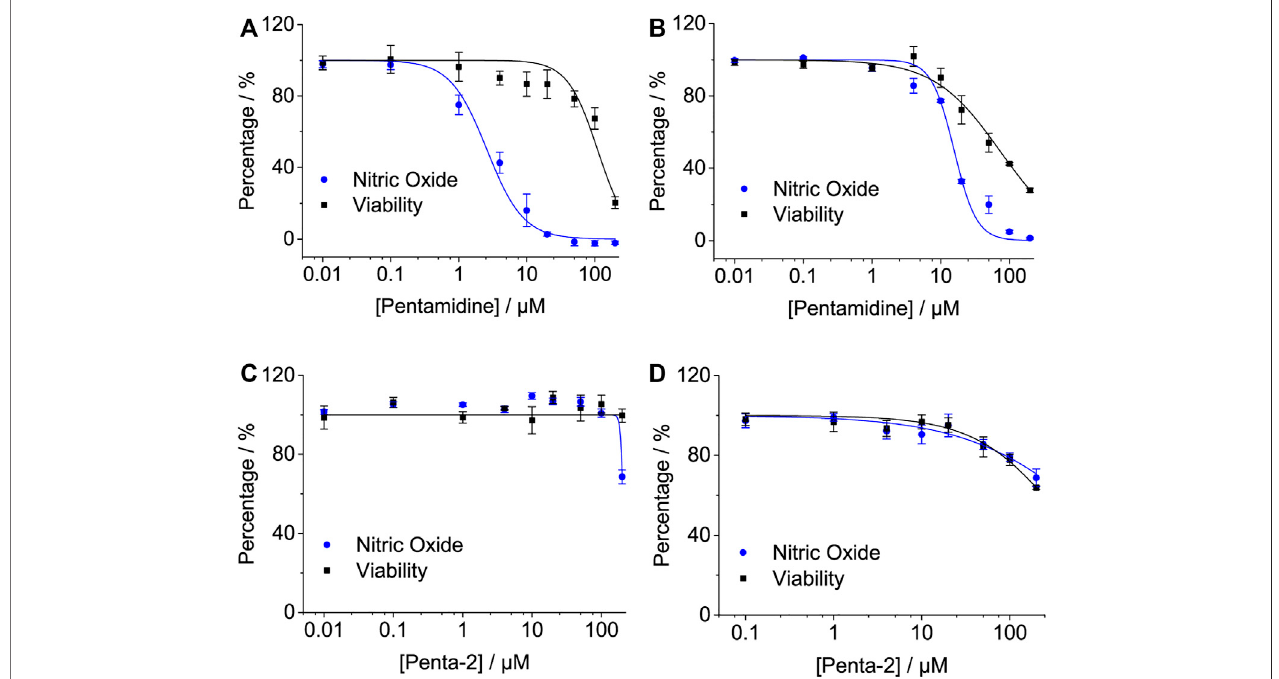
FIGURE 4 | Effects of pentamidine (A,B) and penta-2 (C,D) on LPS-induced NO overproduction in macrophage RAW 264.7 cells (A,C) and BV-2 microglial cells (B,D) . Macrophage RAW264.7 and BV-2 cells were treated with LPS and indicated concentrations of pentamidine and penta-2. After 24 h of incubation, NO in the culture supernatant was measured. The NO production of the LPS treated group without pentamidine or penta-2 was set as 100%, respectively. The cellular viability of pentamidine and penta-2 was also measured by crystal violet staining. All experiments were performed 3 – 4 times independently, and data are given as the mean ±